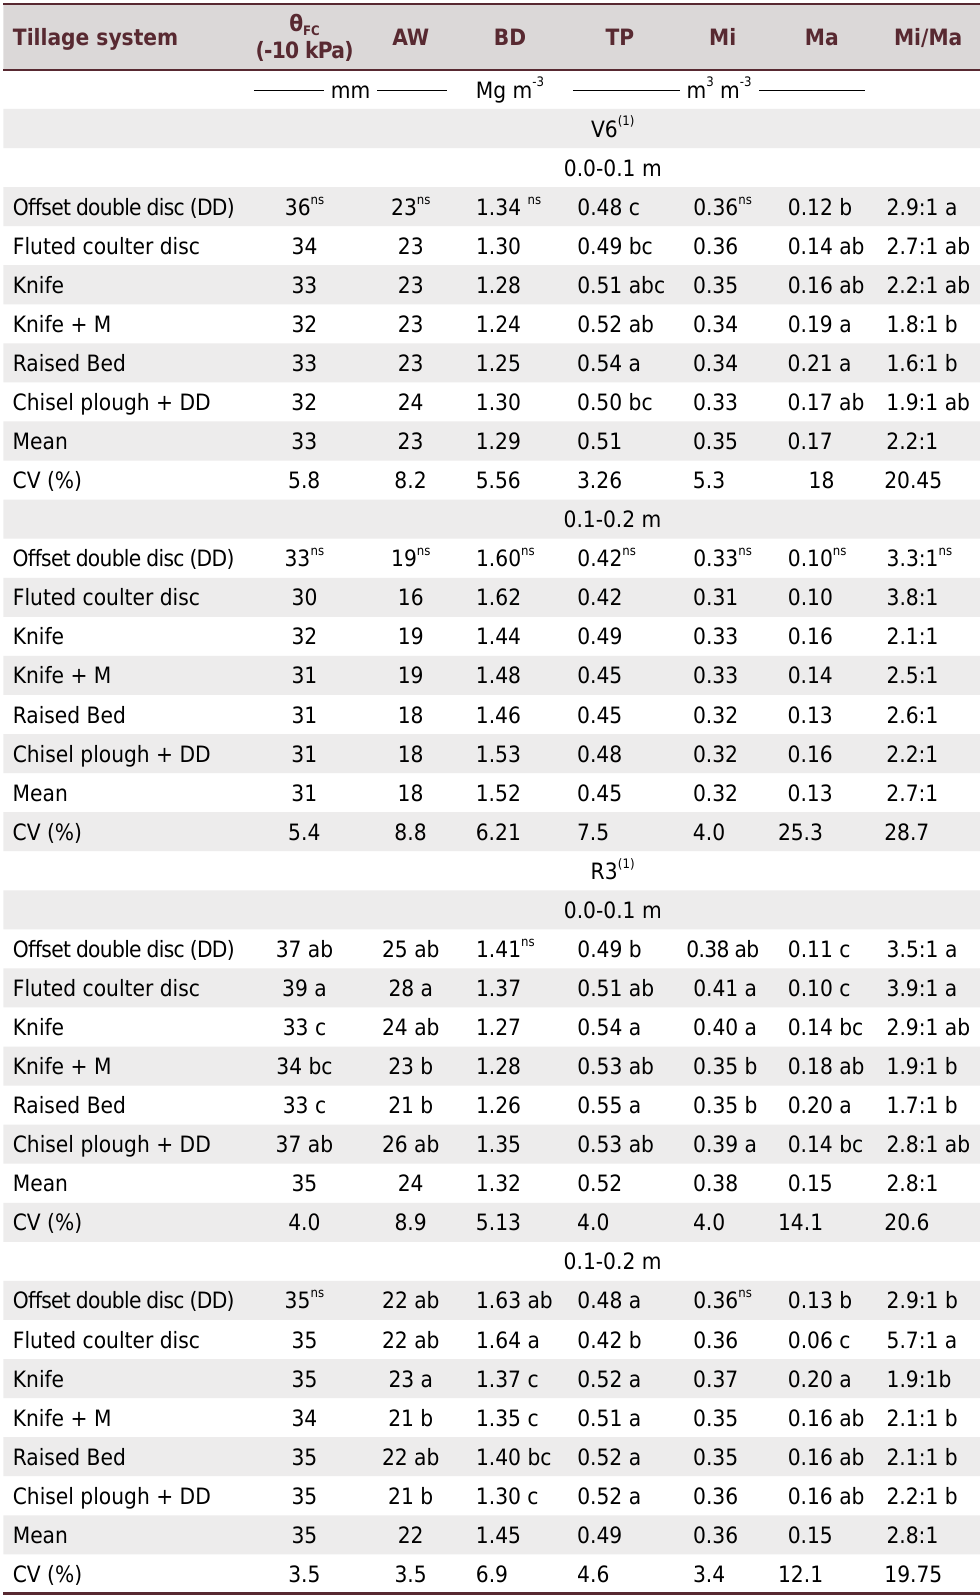
Table 3. Soil water retention at field capacity (Ɵ FC ), available water (AW), bulk density (BD), total porosity (TP), microporosity (Mi), macroporosity (Ma), and Mi/Ma ratio in the treatments at different soil depths. Santa Maria, Brazil. Experiment 1 in the 2013/14 crop season Tillage system